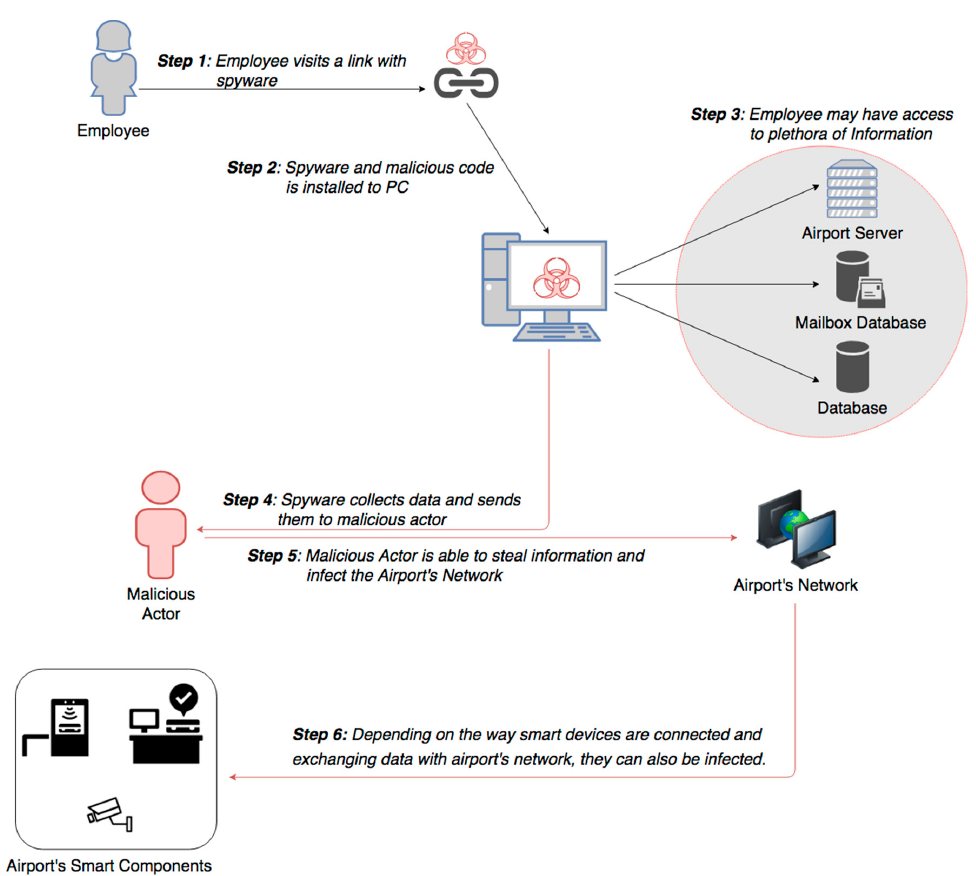
Figure 13. Social engineering attack scenario.